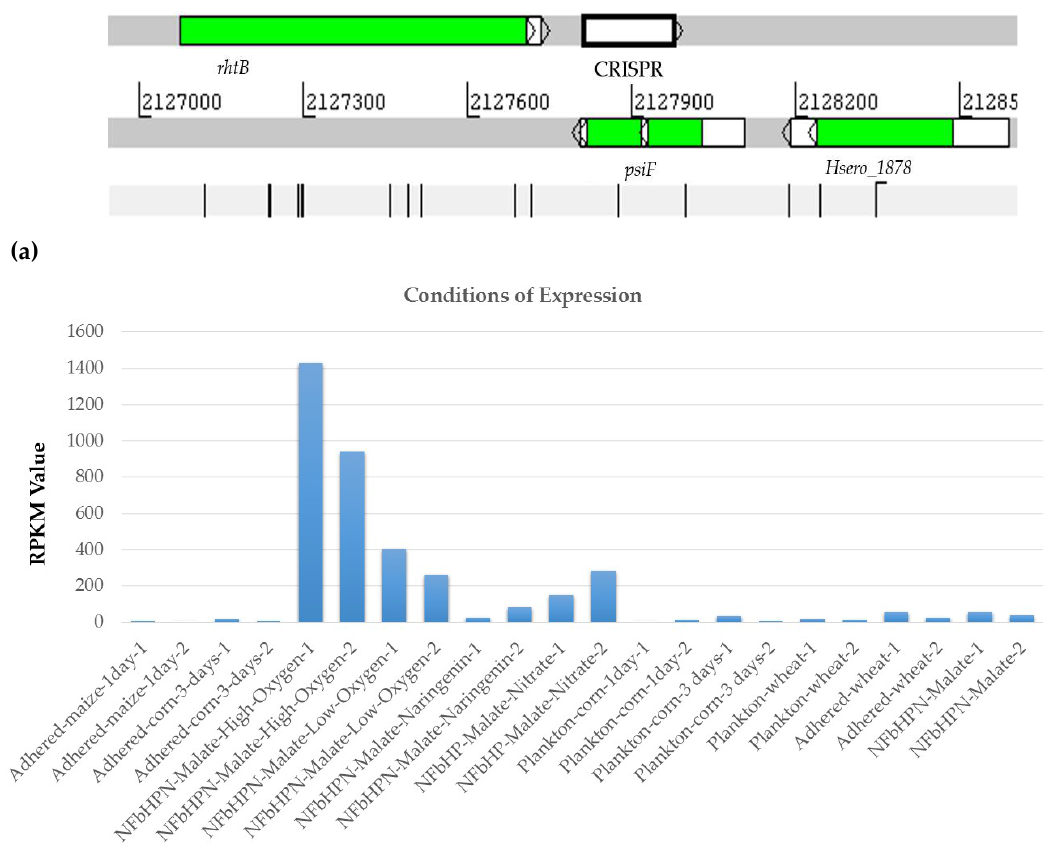
Figure 12. Visualization of the CRISPR locus in the genome of H. seropedicae SmR1. Sense sense in the genome, with 164 nucleotides divided into DR (54 nucleotides) palindromic repetitions and spacing region (57 nucleotides) underlined.